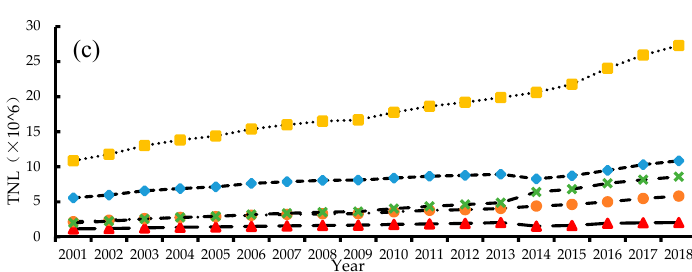
Figure 4. TNL data comparison under different correction methods, Nationwide ( ■ ), Northeastern ( ▲ ), Eastern ( ◆ ), Central ( ● ), Western (×); ( a ) uncorrected; ( b ) corrected in this article; ( c ) reference correction method.